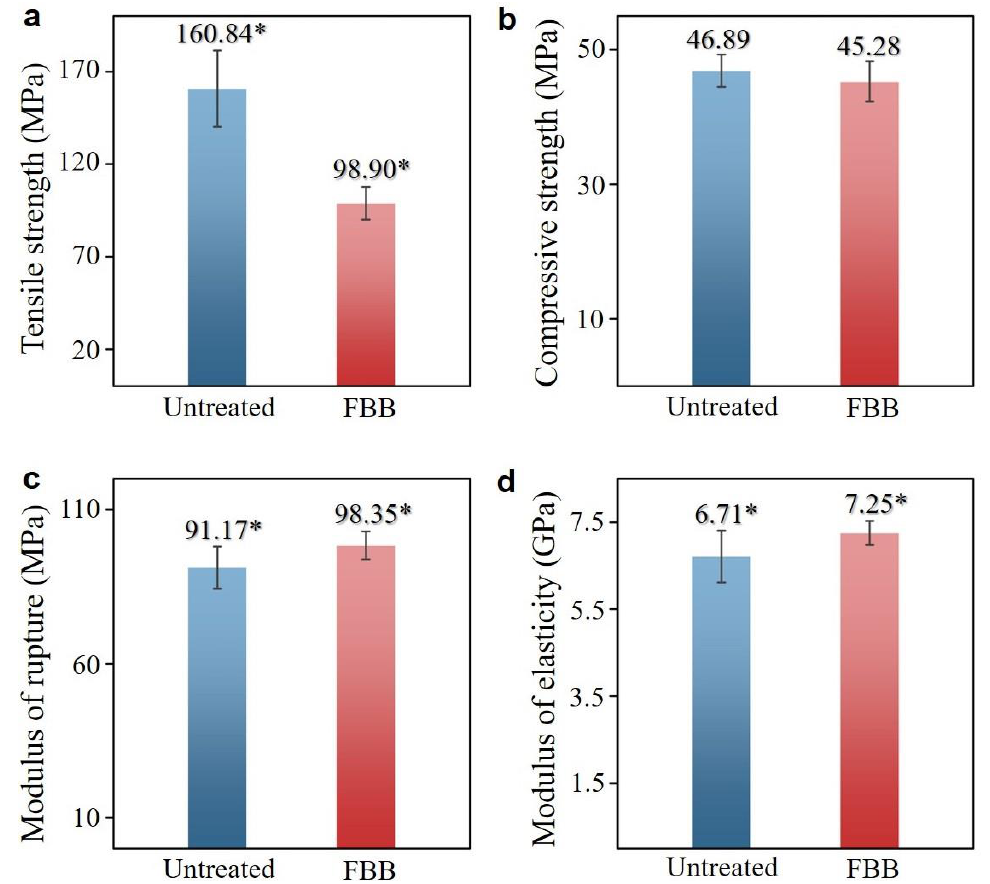
Figure 5. Comparison of ( a ) tensile strength parallel to the grain, ( b ) compressive strength parallel to the grain, ( c ) modulus of rupture and ( d ) modulus of elasticity of bamboo before and after flattening modification. The data in the graph are average values and the error bars represent standard deviations. Values followed by “ * ” indicate that the p -value of the t -test is less than 0.05, and significant differences appear between untreated and FBB data, while unmarked values indicate no significant differences.